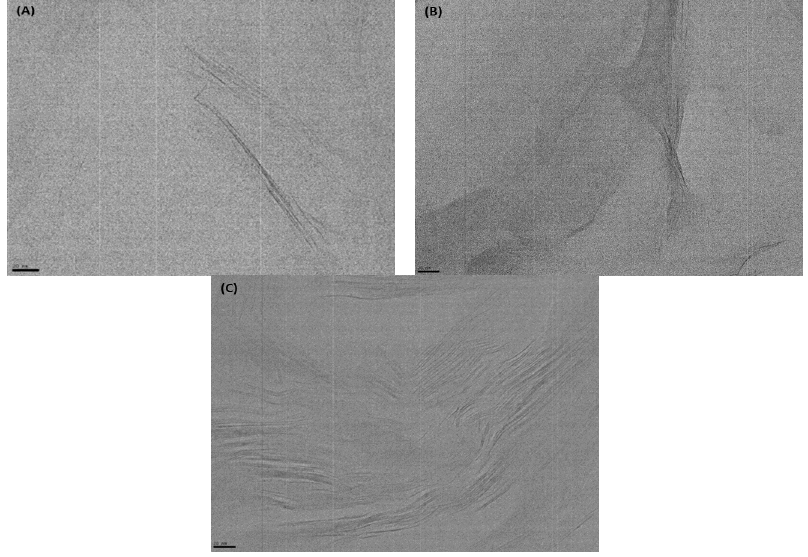
Figure 4. Representative TEM images of partially exfoliated glassy epoxy—clay nanocomposites prepared by 6 wt % I.30E ( A , B ) and of intercalated epoxy—clay nanocomposite prepared by 6 wt % I.28E ( C ). Scale bar = 20